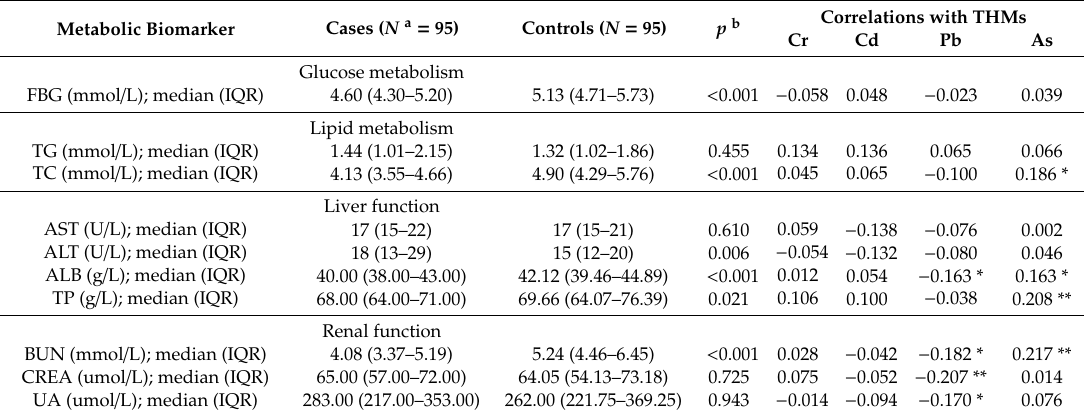
Table 5. Distribution of the metabolic biomarker and their Spearman correlations (rho) with THMs Metabolic